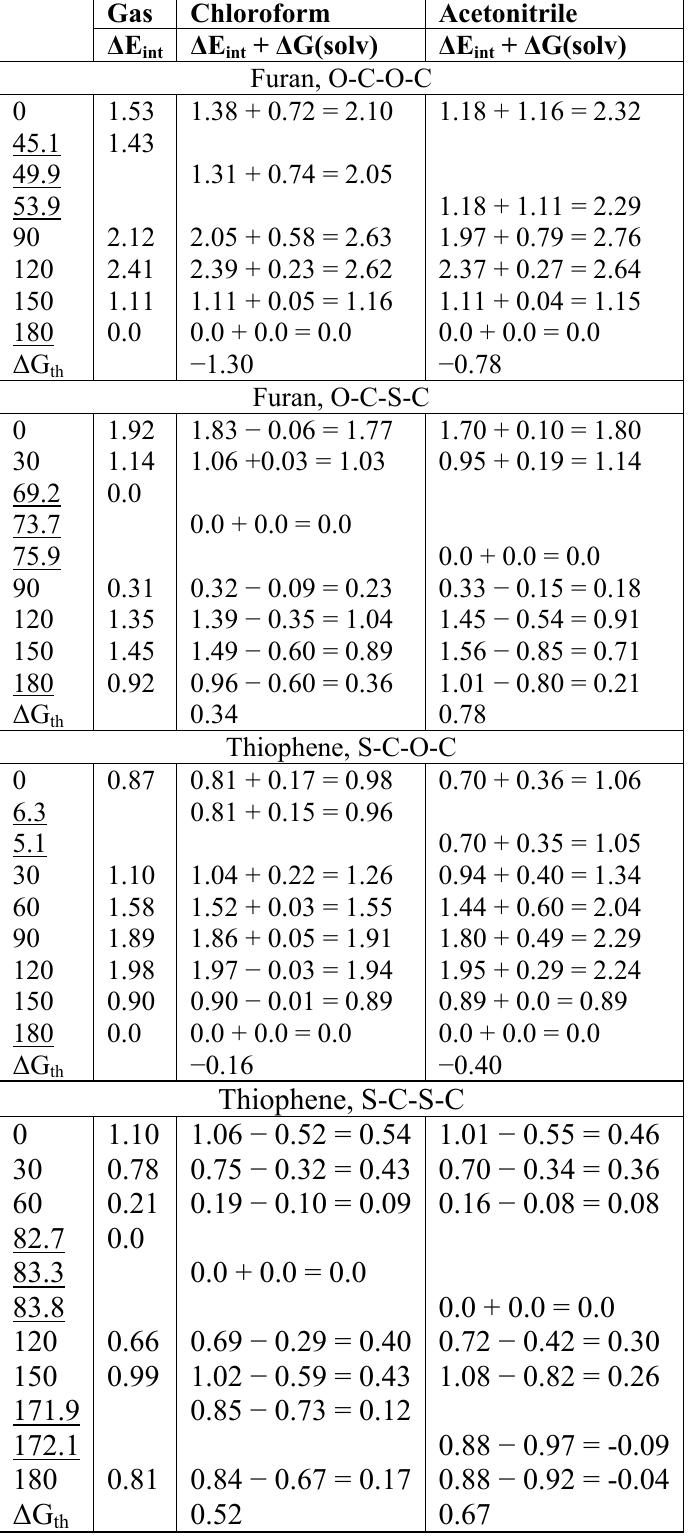
Table 5. Relative energies for ethers as the function of the rotation about the C-O and C-S bonds a